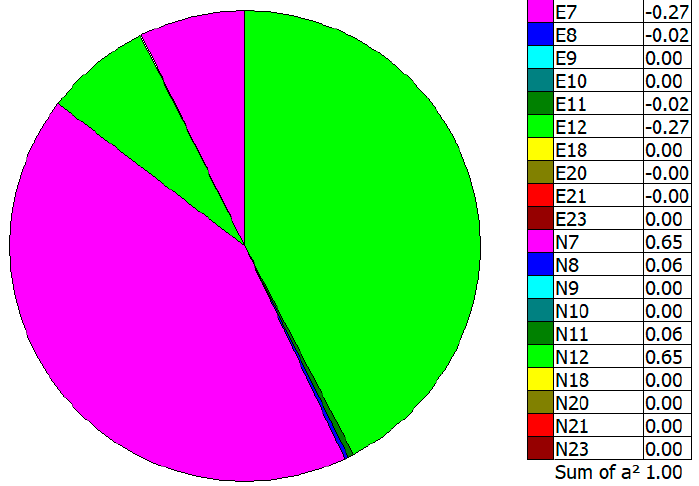
Figure 8. Representative α i for random variables (simplified model).